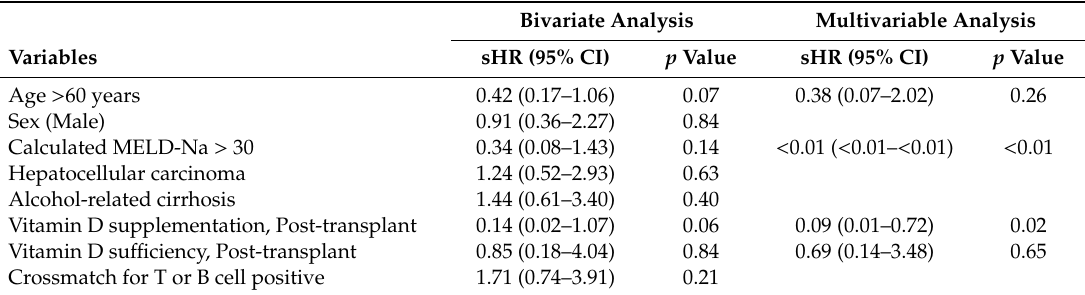
Table 6. Fine and Gray proportional subdistribution hazard model for ACR development in No Supplement and Post